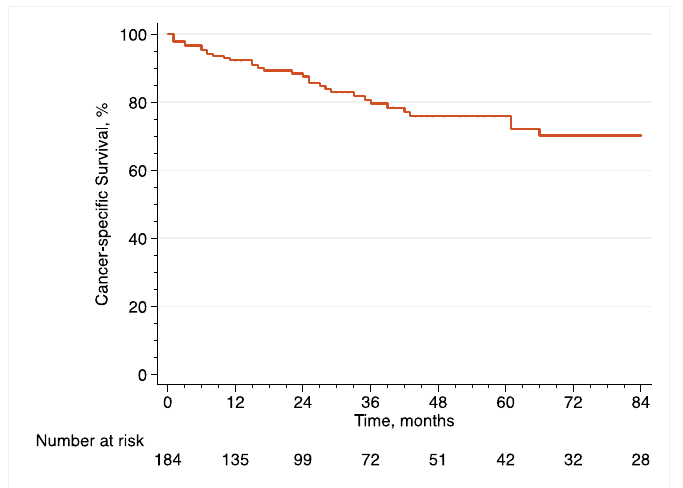
Figure 2. Kaplan–Meier curve that analyses the CSS of included patients treated with eRC for HR- NMIBC.